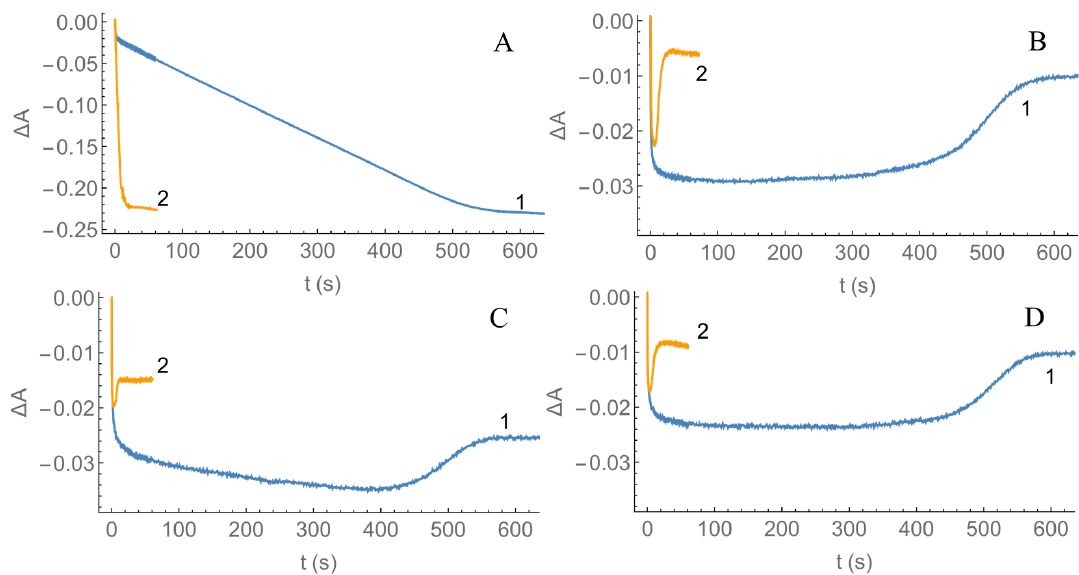
Figure 4. Multiple turnover kinetics of nNOS reduction and reoxidation and NADPH oxidation by O 2 (1) or 100 µ M duroquinone (2) in the absence of CAM. The absorbance changes were followed at 340 nm ( A ), 485 nm ( B ), 397 nm ( C ), and 436 nm ( D ). Concentrations of nNOS and NADPH after mixing, 2.0 µ M and 30 µ M.